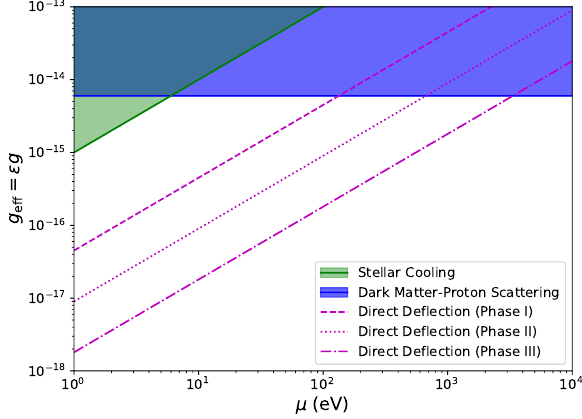
Figure 5 . The maximum value of g eff subject to the constraints of figure 4 as a function of µ , as well as the projected reaches of a direct deflection experiment for the three sets of parameters discussed in [10]. Projected sensitivities for direct detection experiments lie outside of the plotted region, at larger masses and couplings [48,